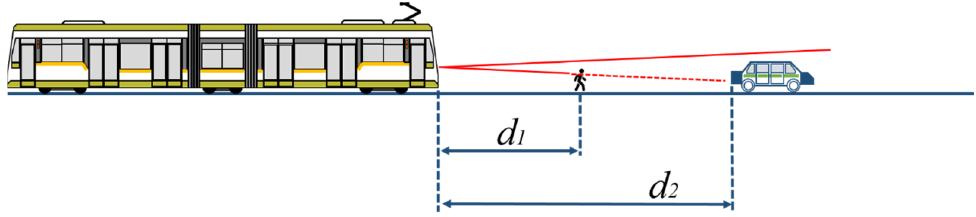
Figure 7. Pedestrian obstacle LiDAR measurement.